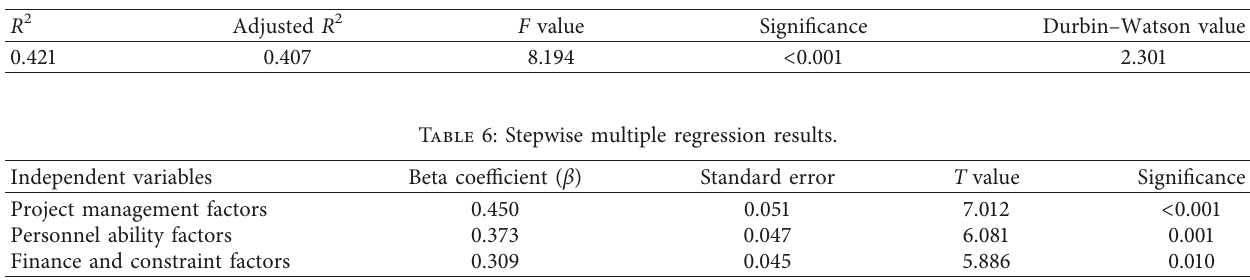
Figure 5: Specific process of stepwise regression analysis. Table 5: Model fitting result.